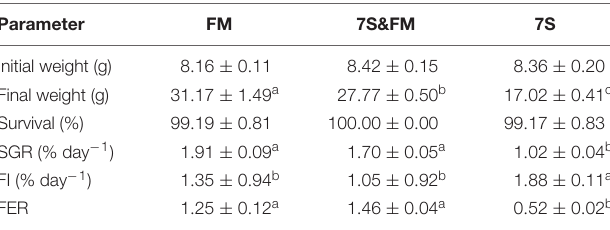
Values are means ± standard error, and values within the same row with different letters are significantly different (P < 0.05). SGR: specific growth rate; FI: feed intake; FER: feed efficiency